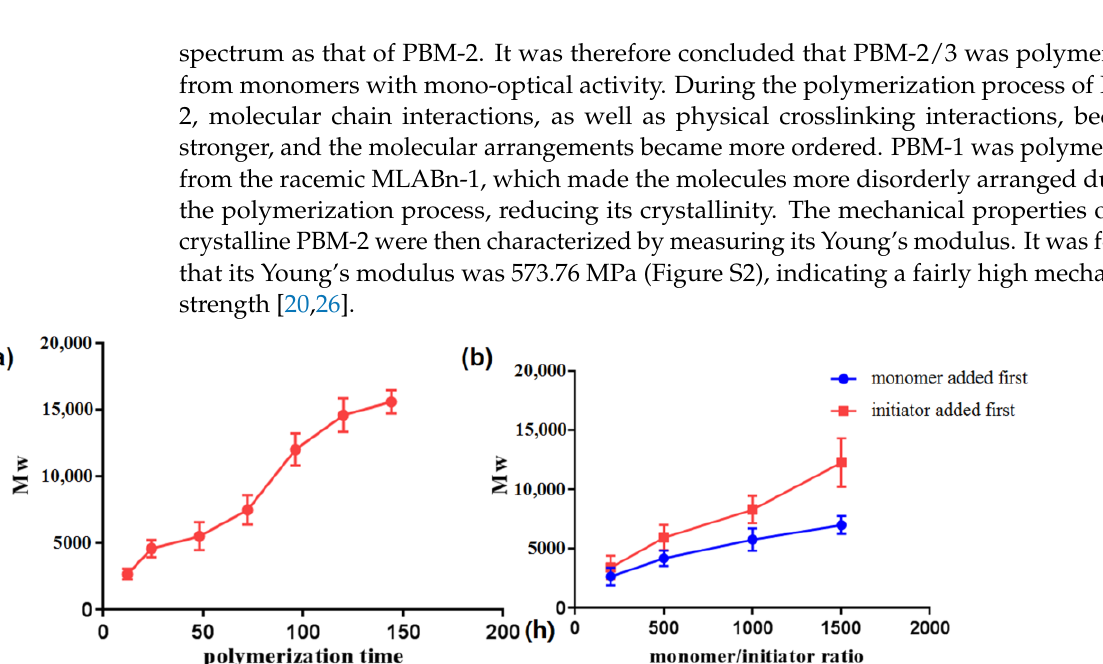
Figure 3. The influence of the polymerization time ( a ), monomer/initiator ratio, and the added se-